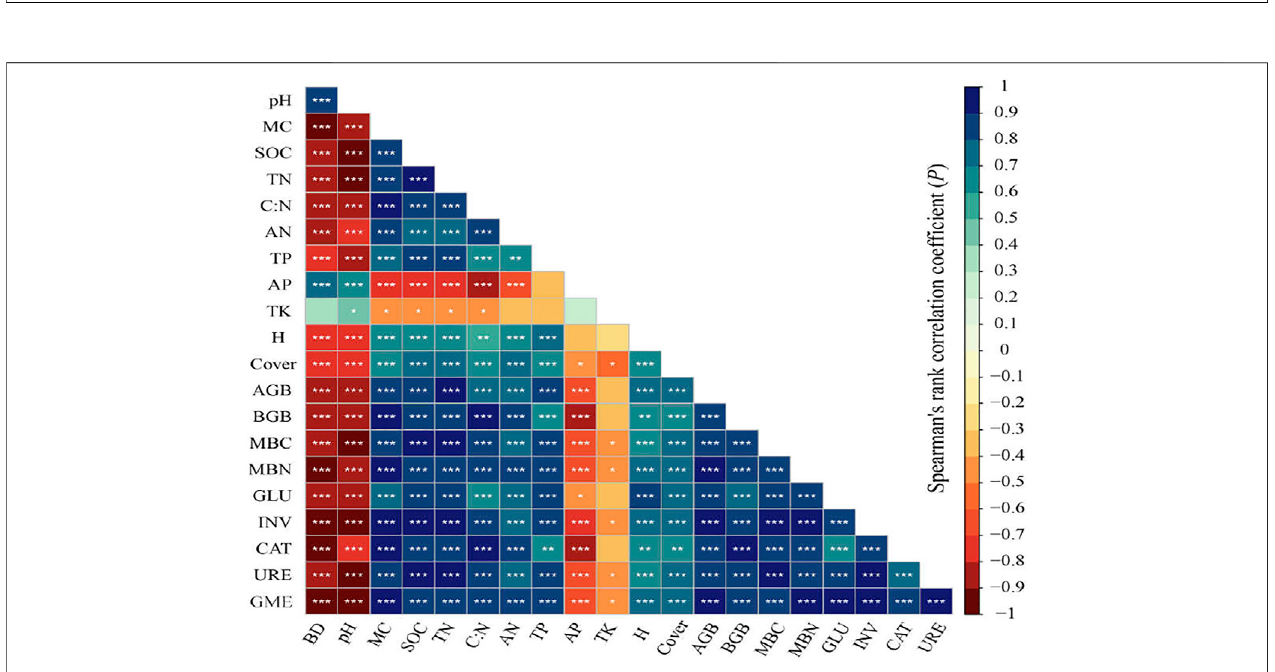
FIGURE4| Distributionofthegeometricmeanofenzymeactivity (GME)atthesoil0 – 50 cmdepth (A) andtheaverageGMEindifferentsites (B) .SF,soybean fi eld; R1,R4,R8,R13, R17,and R27, restored sites after 1,4,8, 13,17, and 27 years offarmland abandonment; NM,natural marsh. Differentlowercaselettersin (A) indicate signi fi cant differences between different layers in the same site ( p < 0.05). Different uppercase letters in (B) indicate signi fi cant differences of the average value of the fi ve layers between different sites ( p < 0.05).